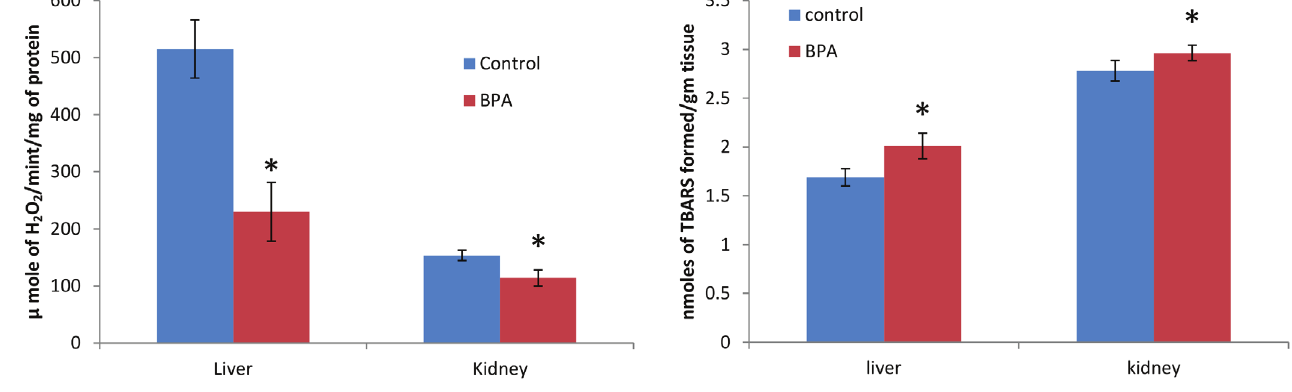
FIGURE 4 - Lipid peroxidation in the liver and kidneys of C. idella (n=5), exposed to the sublethal concentration of BPA for 14 days . Values given are mean ±S.E.M. * =